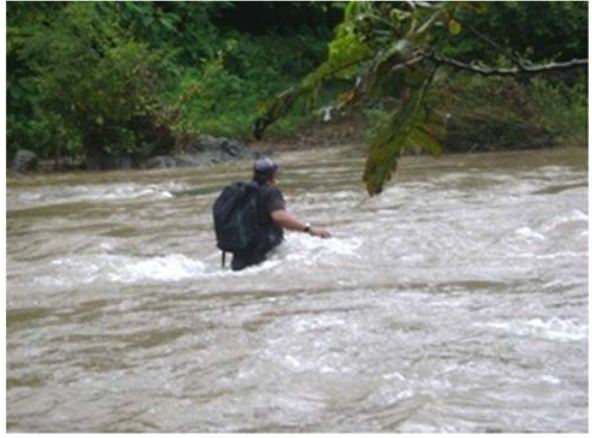
Figure A3. Health workers after a flood bringing health care to an affected population in Achuapa, Nicaragua (photo credit: Gilberto Moreno).